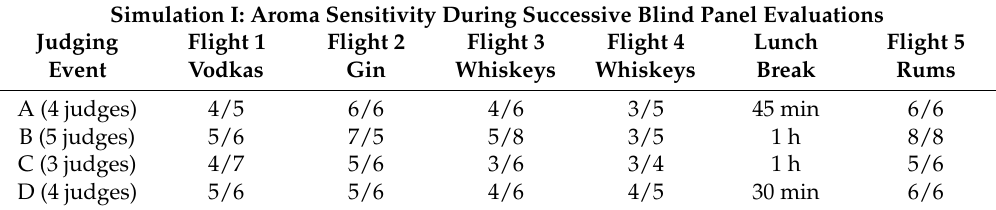
Table 5. Aroma sensitivity during successive blind panel evaluations (aromas/samples). Panel evaluation events with copita vessels. Number of aromas is the sum total of different aromas collected from individual notes. Brown, barrel-aged spirits generally display significantly more aromas than clear. In all events, during the third flight, fewer brown spirit aromas were noted than from clear spirits in prior flights. Audible comments regarding aroma detectability began early during the third flight for each event. Red denotes fewer identified aromas than the previous flight despite a more aroma-laden category. Conversations with evaluators using traditional vessels indicate awareness of difficulty during the third flight of an event. Details in Section 2